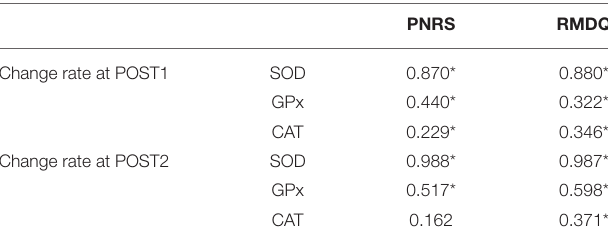
TABLE 4 | Correlations between the change rates in pain-related indices and antioxidant